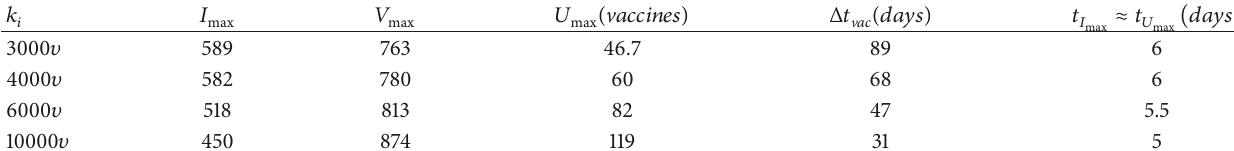
Table 2: Specifications of the vaccination campaign for the different values of 𝑘 𝑖 .